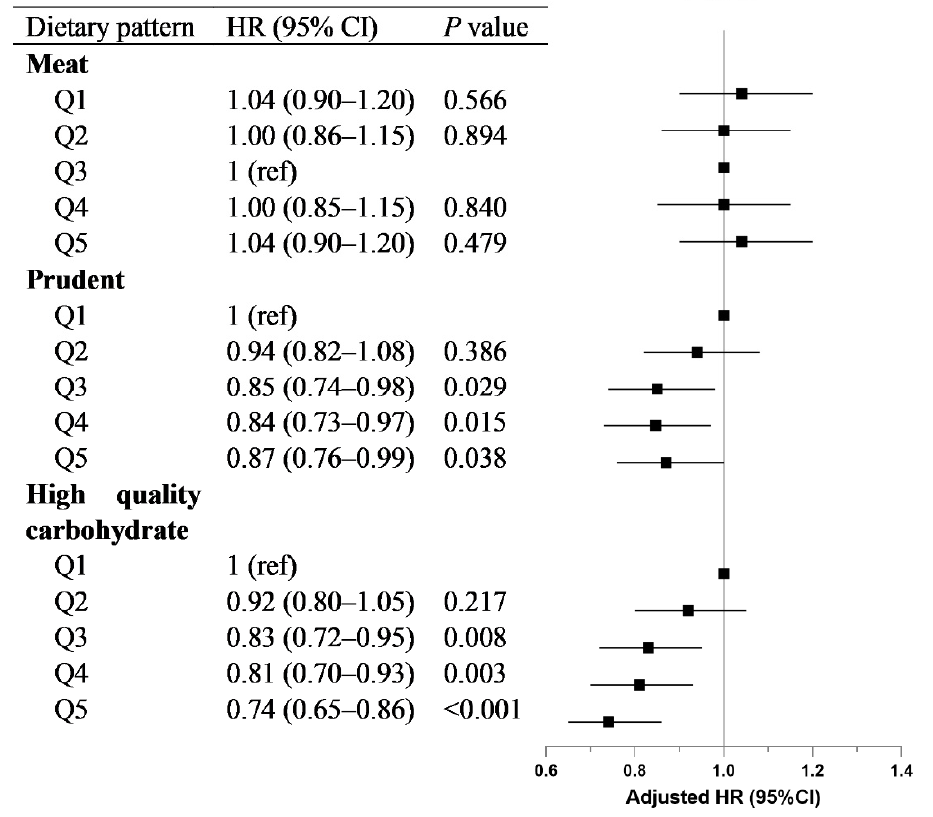
Figure 1. Association of dietary patterns with incident ESLD. For the meat diet pattern, the quintile with the lowest hazard ratio (Q3) was set as a reference. The model was adjusted for age, sex, ethnicity, Townsend deprivation index (quintiles), education level (university/college degree or others), household income (less than £18,000, £18,000 to £30,999, £31,000 to £51,999, £52,000 to £100,000, greater than £100,000 or do not know/prefer not to answer), self-reported smoking status (never, former or current smoker), sedentary behavior, body mass index, baseline diabetes, baseline hypertension, serum alanine aminotransferase, triglycerides and cholesterol.